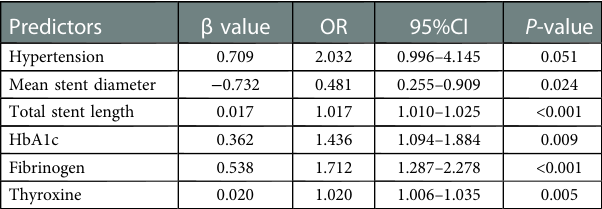
TABLE 2 Multivariate logistic regression analysis of